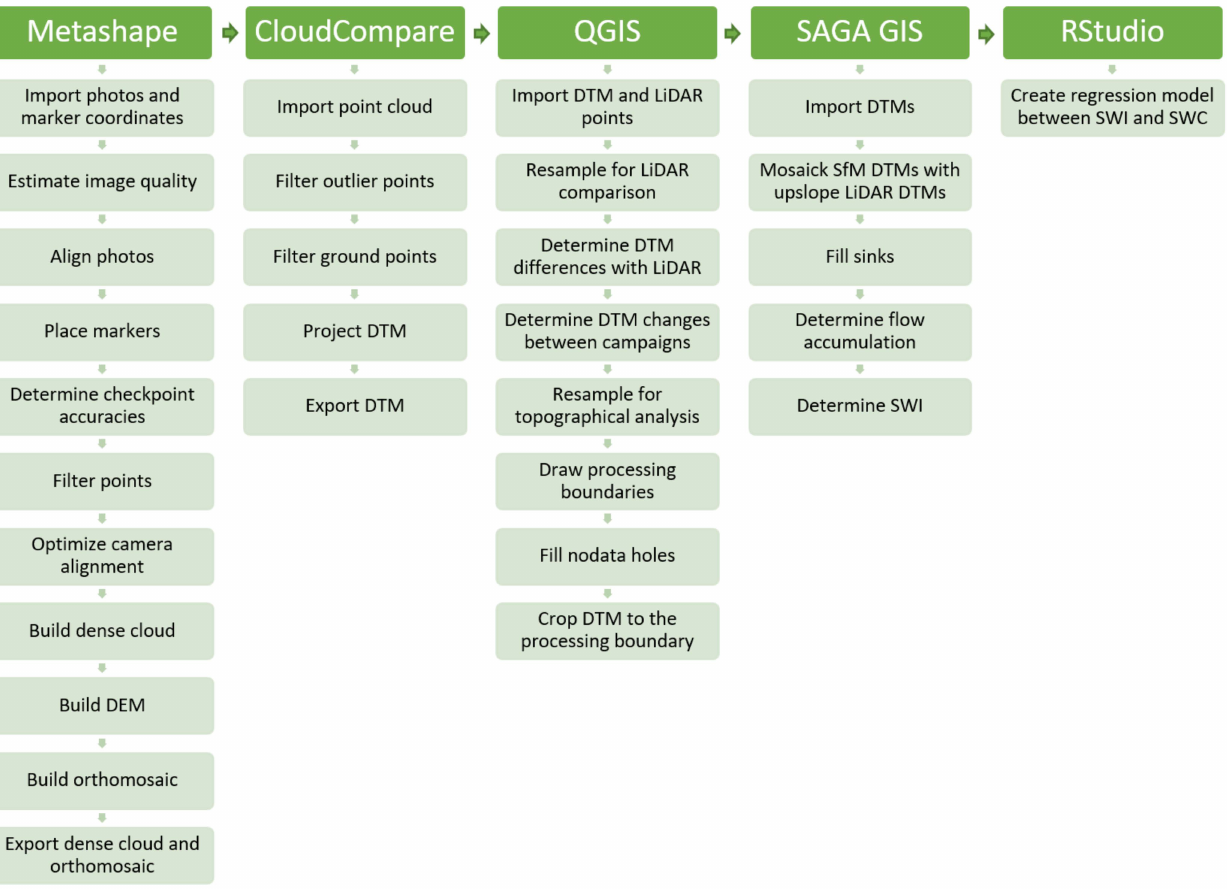
Figure 4. The data processing workflow of the software. The steps were applied for the data from restoration sites to reveal the impacts of ditch infilling and damming, and for the data from pristine control sites for the impacts of